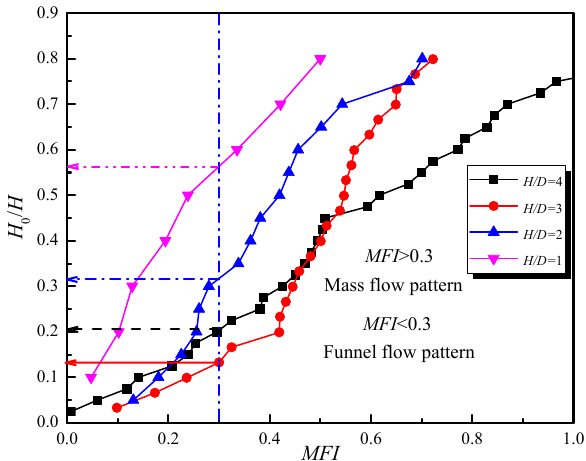
Figure 6. Variation in mass flow index ( MFI ) as a function of normalized sinter layers for different aspect ratios.